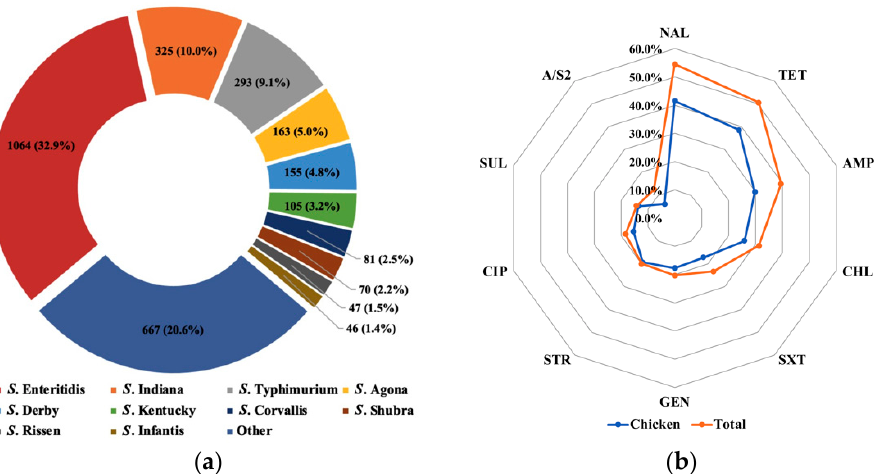
Figure 1. The flowchart of the literature searching and collecting.